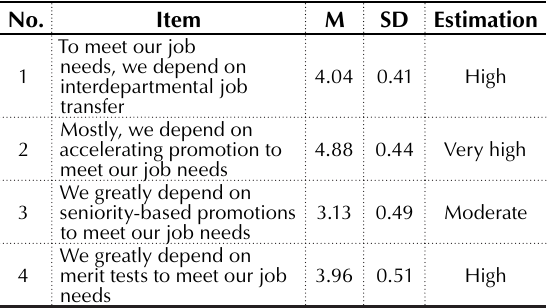
Table 1. Means, standard deviation levels of internal recruitment sources